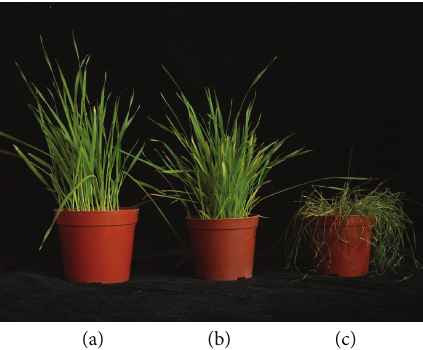
Figure 1: The seedlings of naked oats at normal temperature (a) and low temperature of 1 ∘ C (b) and − 10 ∘ C (c) after 7 days.